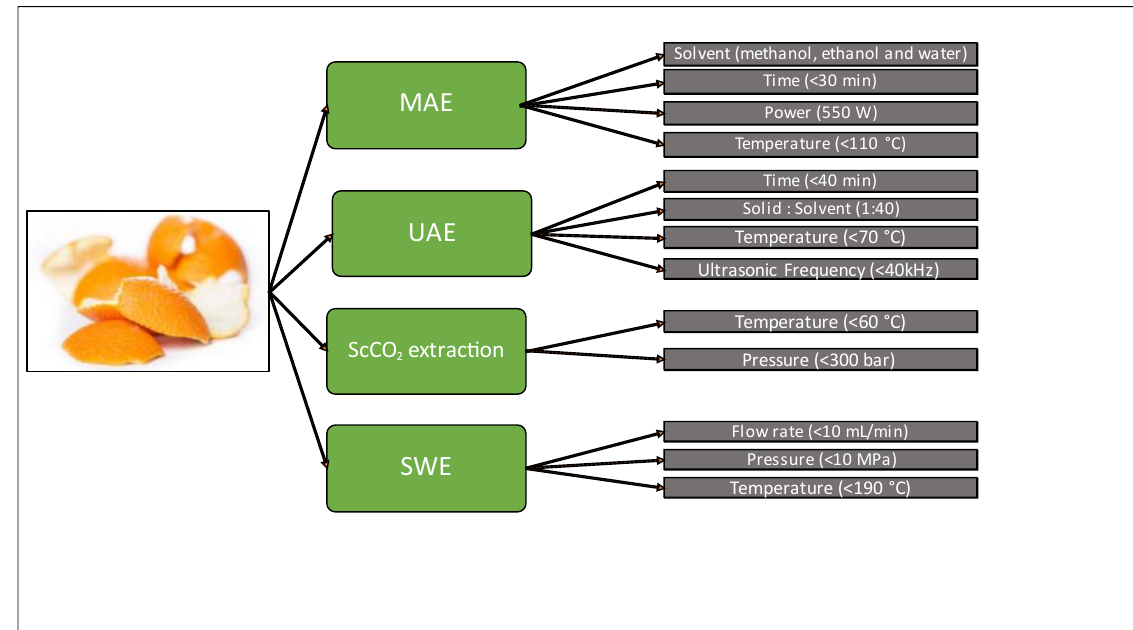
Figure 4. Influenced parameters on the orange peel and pomace valorization using green extrac- tions.